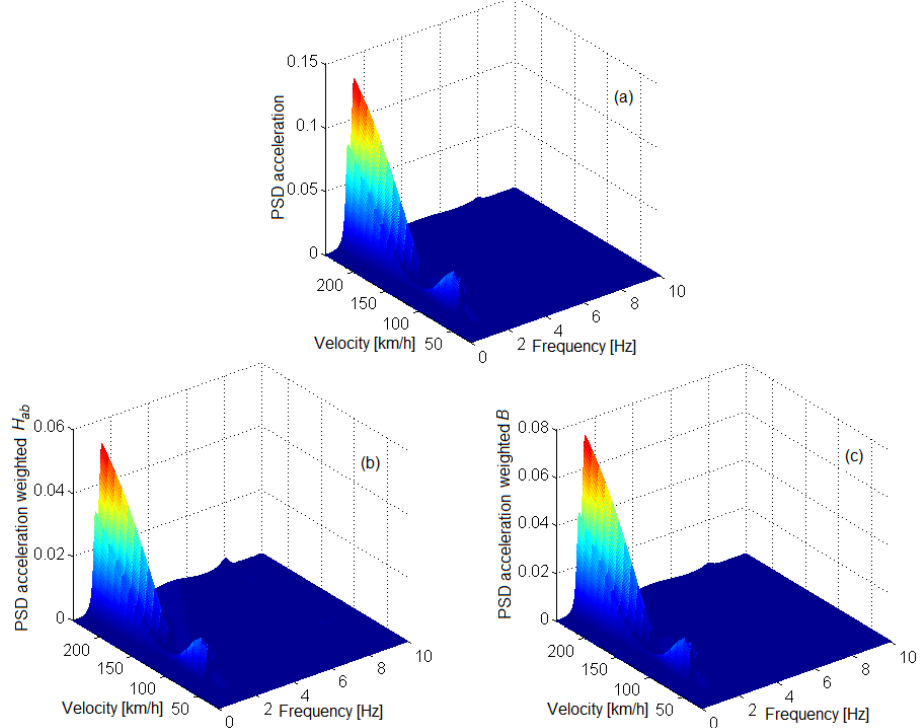
Figure 8. Correlation between ride comfort index N MV and ride comfort index W z .Power spectral density of acceleration (PSD acceleration) in reference point B 2 in (m/s 2 ) 2 /Hz: ( a ) unweighted; ( b ) weighted with weighting function H ab ; ( c ) weighted with weighting function B.